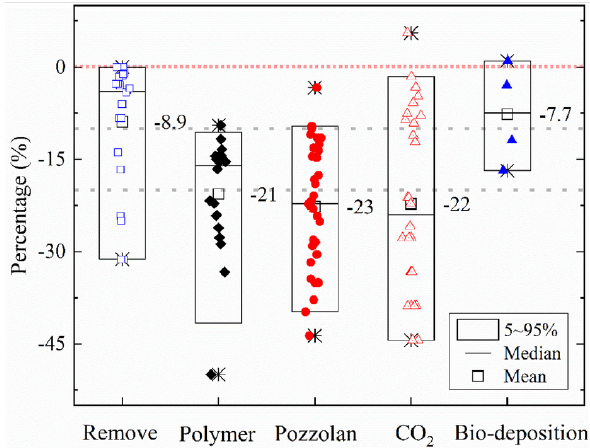
Figure 4: The influence of different processing methods on crushing index [42].